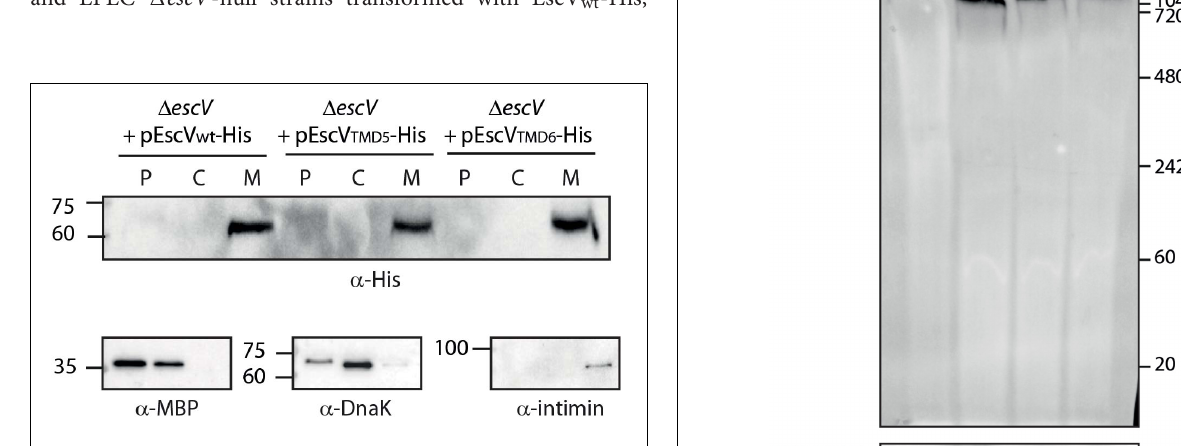
FIGURE 5 | Replacement of EscV TMDs by an alternative hydrophobic sequence does not affect membrane localization. EPEC (cid:49) escV strain expressing EscV wt -His, EscV-TMD5 ex -His and EscV-TMD6 ex -His were grown under T3S-inducing conditions, were fractionated into periplasmic (P), cytoplasmic (C), and membrane (M) fractions and analyzed by western blot analysis with an anti-His antibody. Proper bacterial fractionation was confirmed by analyzing the samples by SDS-PAGE and western blotting with anti-DnaK (cytoplasmic marker), anti-MBP (periplasmic marker), and anti-intimin (membrane marker) antibodies.